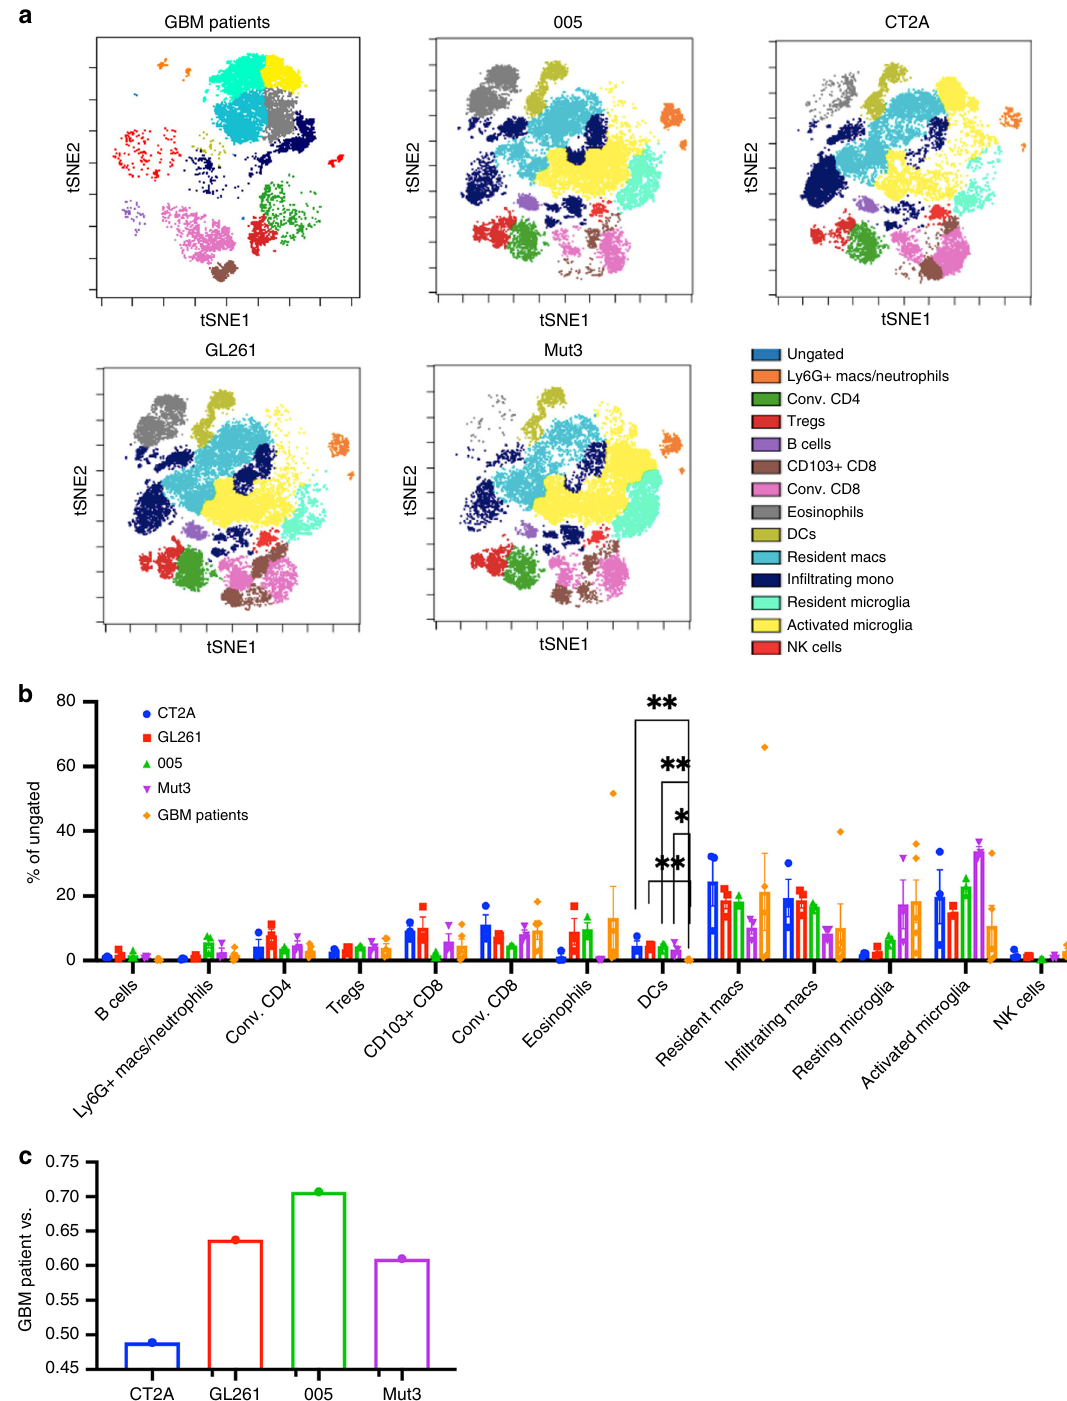
combining the power of RNA sequencing and CyTOF. Our fi ndings show differences in immune-cell subsets in four syn- geneic mouse tumor models allowing us to identify immunolo- gically inert and active tumor types. CyTOF analysis revealed that the identity of immune cells and their activation status was dif- ferent in the immunologically active vs. inert tumors. Finally, we show that immunologically inert GBM tumors in mice can be activated by surgical intervention, a standard of care procedure for GBM patients.